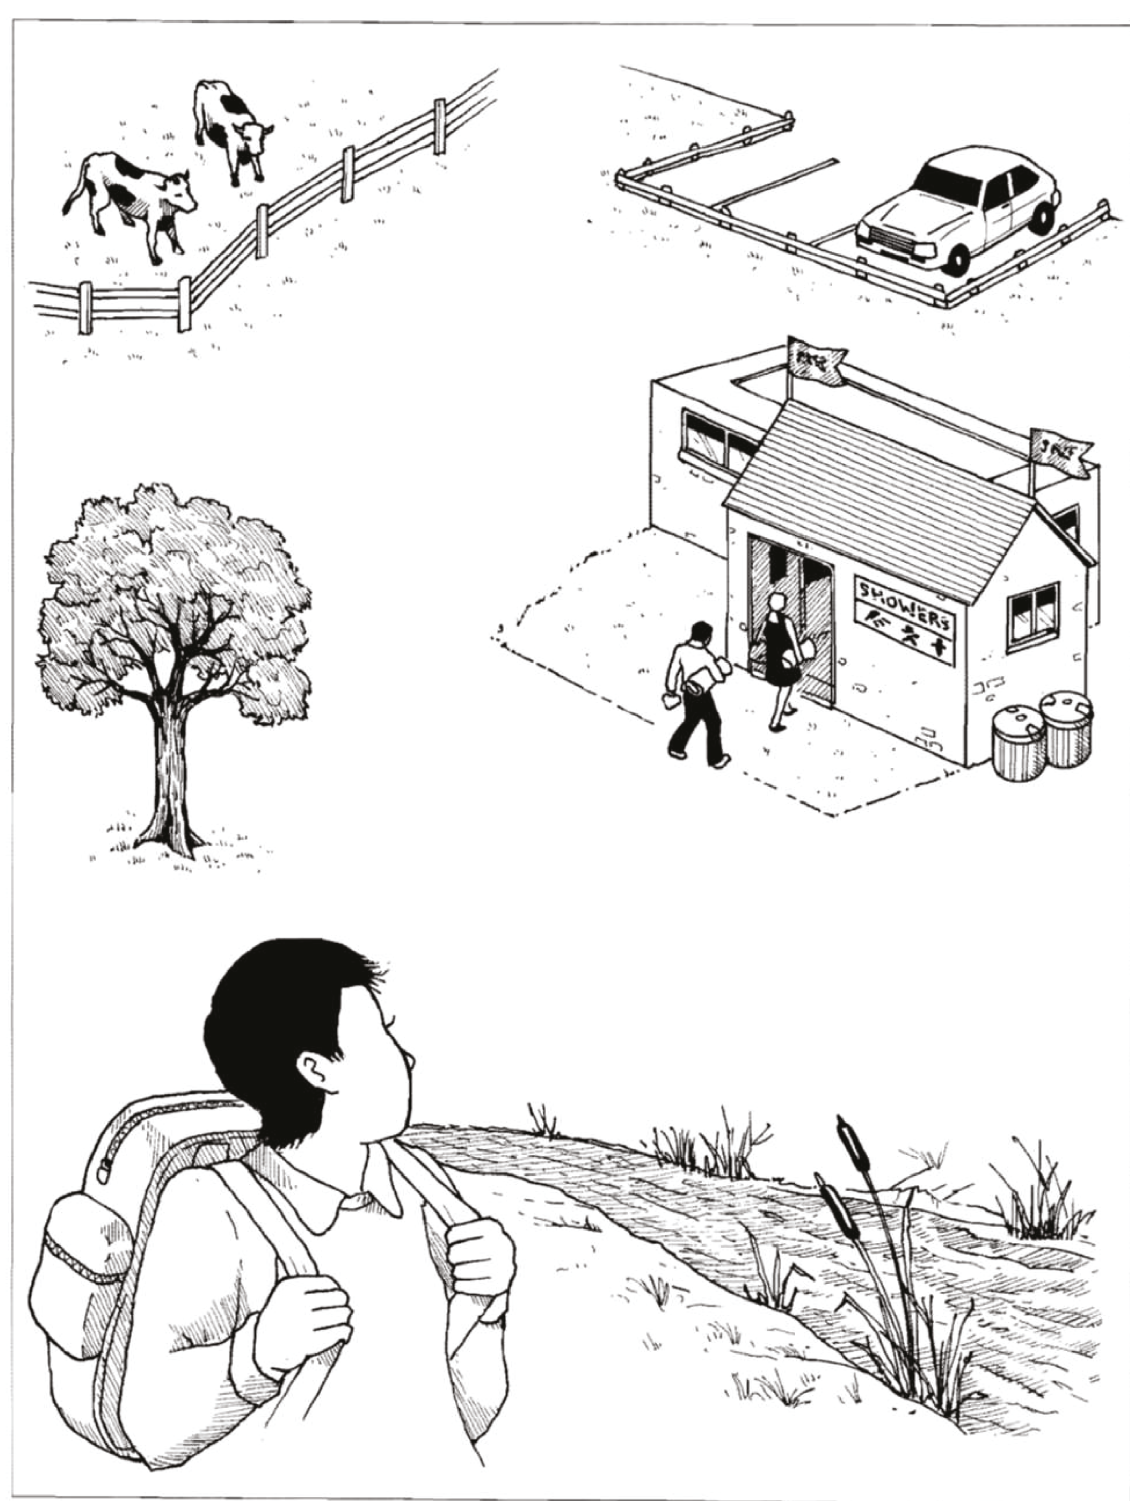
Figure 4: Post-test page